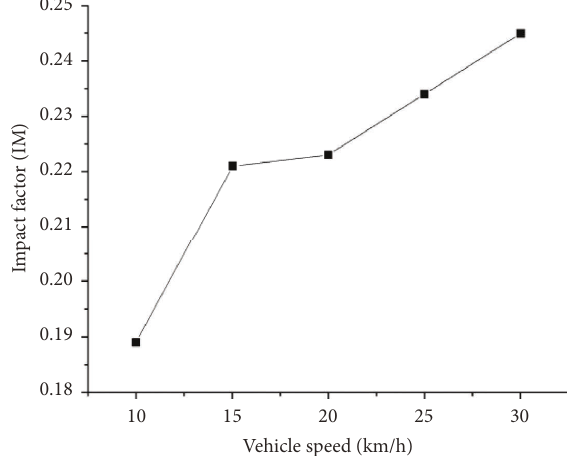
Figure 18: The impact factor at